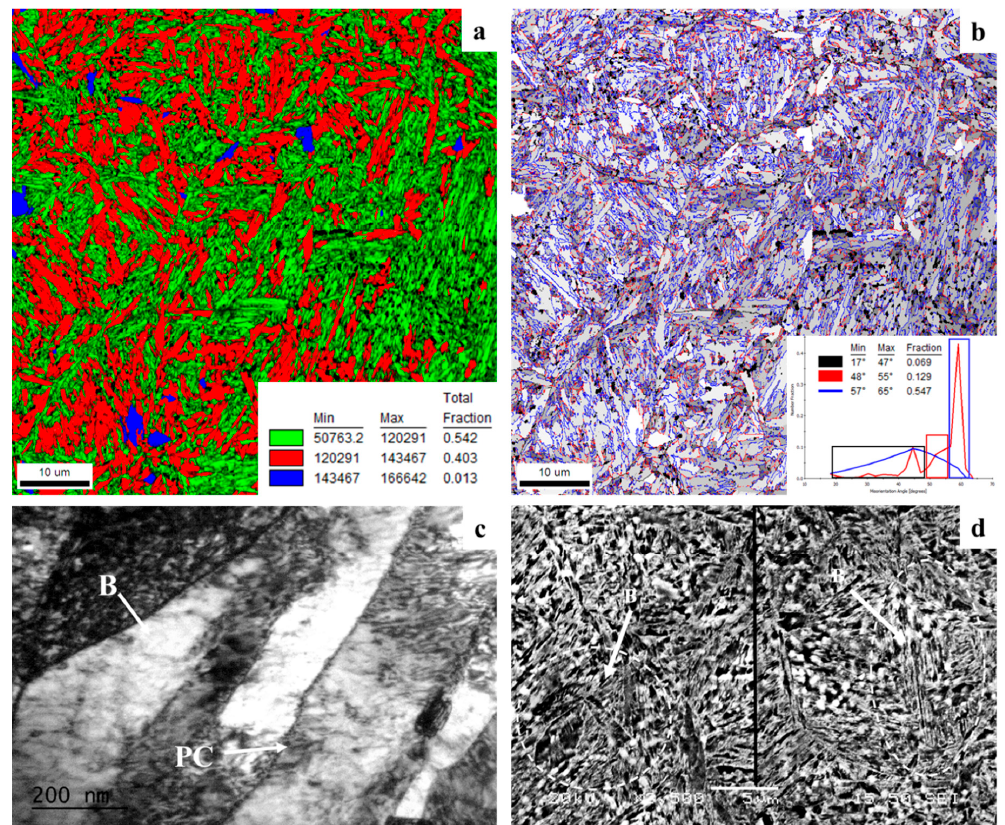
Figure 7. ( a ) Color coded GAIQ map for the UFH sample. Martensite is indicated in green, ferrite in blue while low-carbon martensite and bainite in red, ( b ) gray-scale GAIQ map of the same area with misorientation angles indicating the boundaries between PAGs (black), bainite (red) and martensite (blue), ( c ) The presence of bainite has been observed in TEM and ( d ) in SEM. The two SEM micrographs indicate the presence of bainitic areas in the